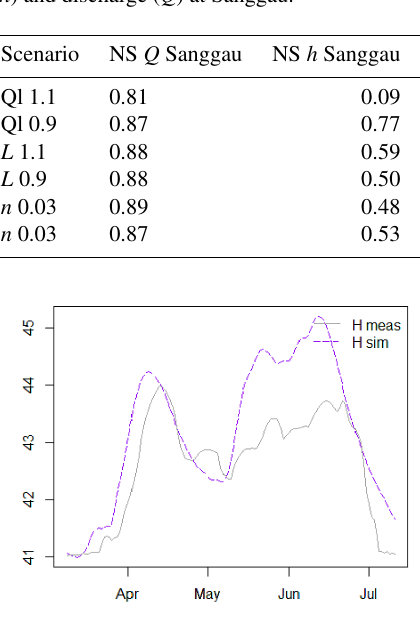
Figure 3. Simulated (dashed line) and measured (solid line) water levels (metres above sea level) of the Kapuas lake.